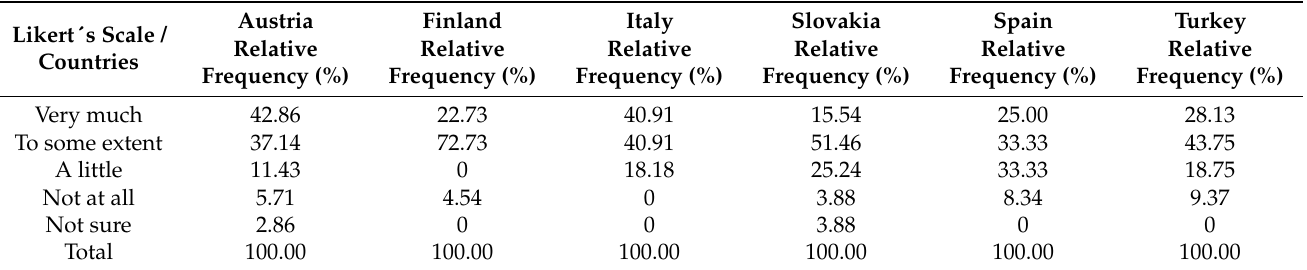
Table 6. The data comparison of the extent to which the sustainability principle informs the work in an organisation, according to participating countries (own elaboration,